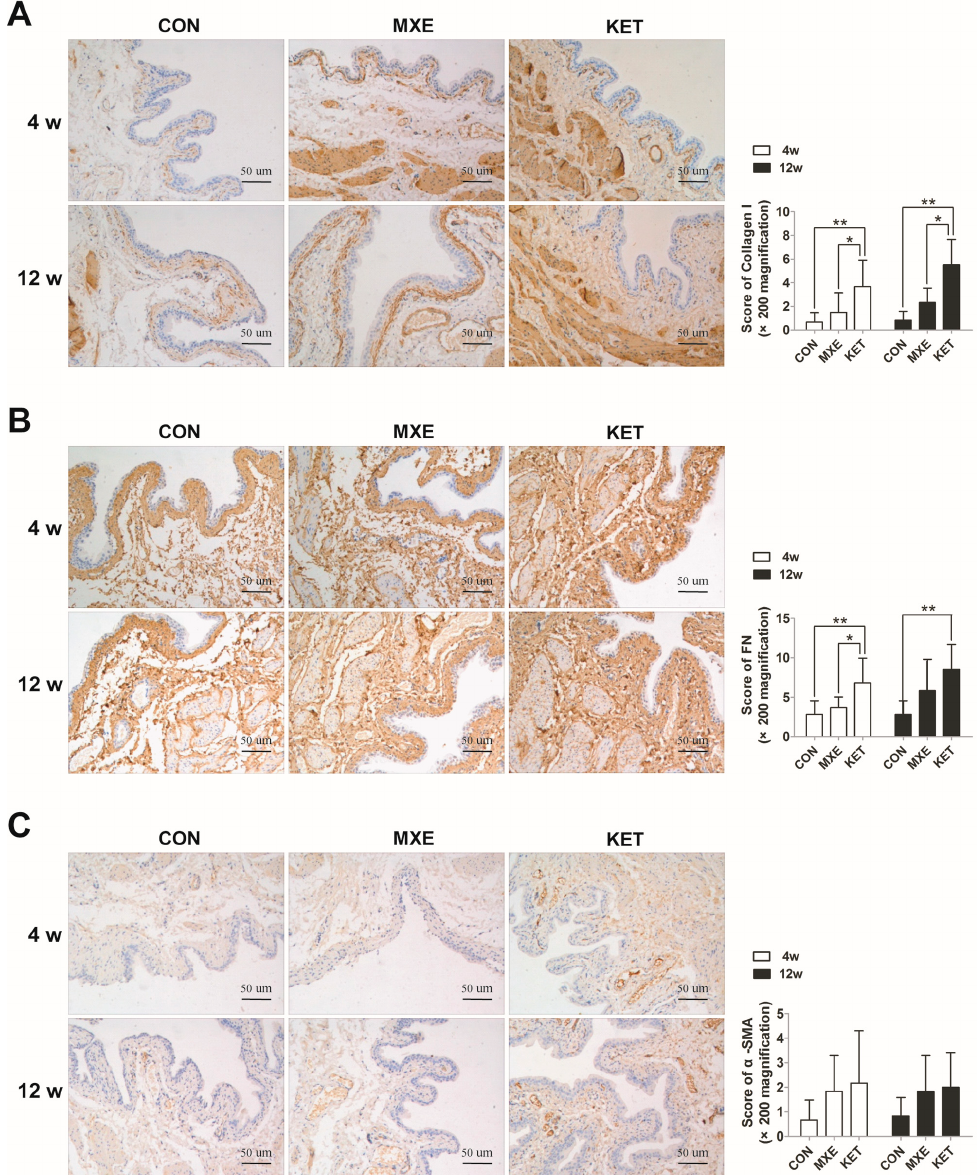
Figure 8. Immunohistochemistry of: collagen I ( A ); fibronectin ( B ); and α -SMA ( C ) in bladder tissue of normal saline, methoxetamine and ketamine treated rats ( n = 6 in each group). A trend of increasing interstitial fibrosis with prolongation of exposure time was observed in the MXE group or KET group. Data are expressed in mean ± SD, as the fold-change vs. the mean value in the control group at 4 weeks. Two-way ANOVA were used for analysis. * p < 0.05, ** p < 0.01. 2.6. Direct Toxic and Pro-Inflammatory Effects on Bladder Epithelial Cells In Vitro